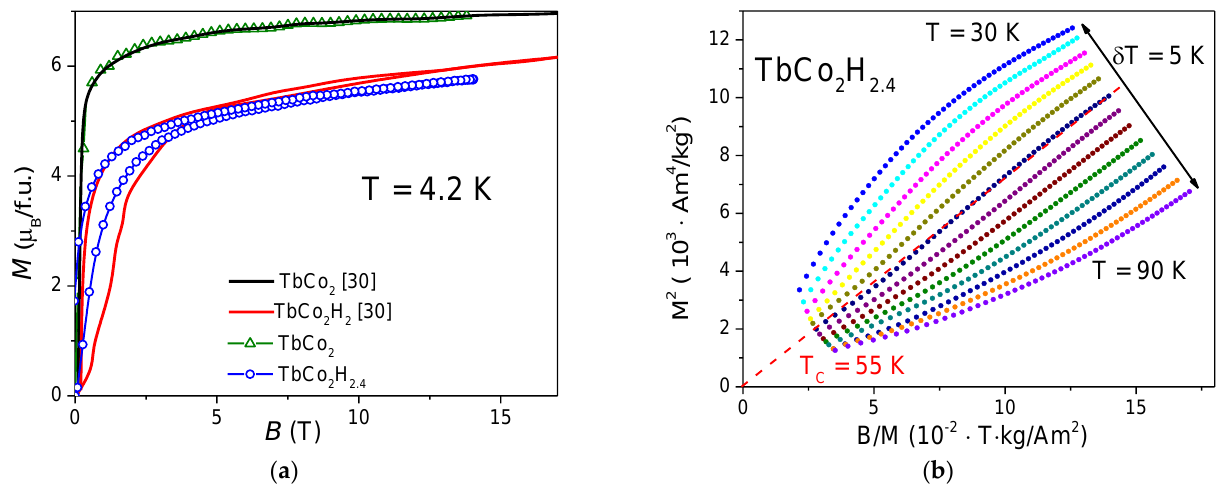
Figure 2. ( a ) Field dependence of the magnetization of the initial compound TbCo 2 and its hydrides TbCo 2 H 2 and TbCo 2 H 2.4 ; ( b ) the Curie temperature determination of the TbCo 2 H 2.4 hydride by the Belov – Arrott method.